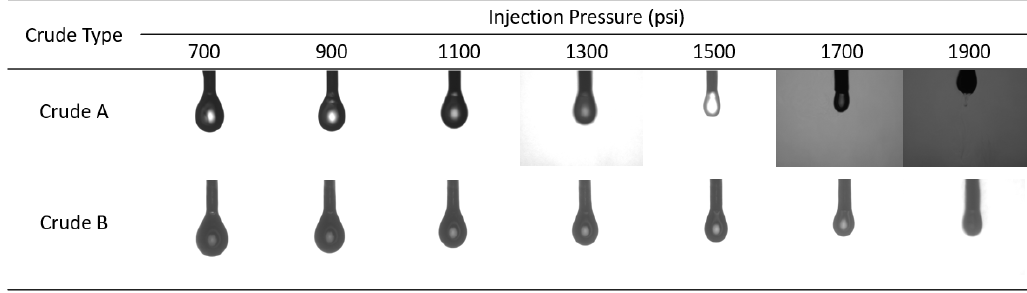
Figure 5. Oil-drop images at CO 2 injection pressures and crude oil samples at 60 o C. 193